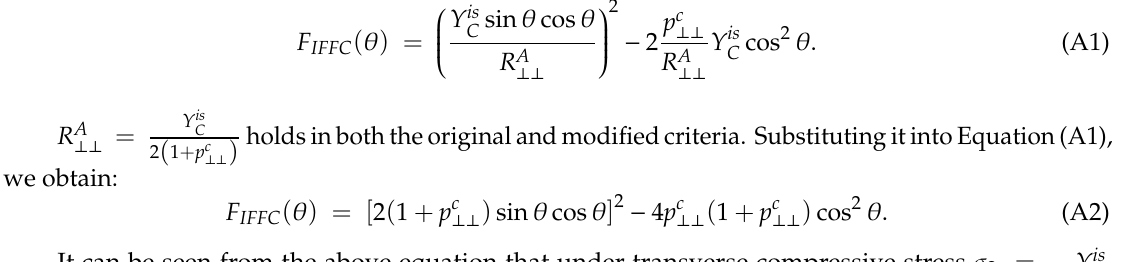
is Y . According C